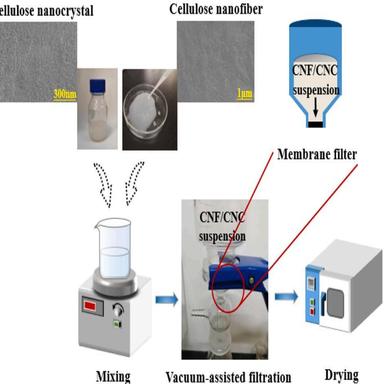
Schematic of the fabrication process of CNF/CNC nanocomposite films.